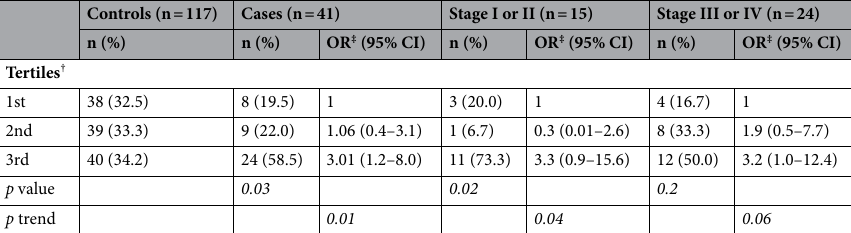
Table 2. Observed bile sCD14 levels by GBC case and gallstone control status. † Bile sCD14 cutoffs among GS controls: tertiles < 16,676 pg/mL (first), ≥ 16,676 and < 81,906.4 pg/mL (second), ≥ 81,906.4 pg/mL (third). ‡ Odds ratio adjusted for sex and age. p value: Fisher’s exact test; p trend: Wald test.